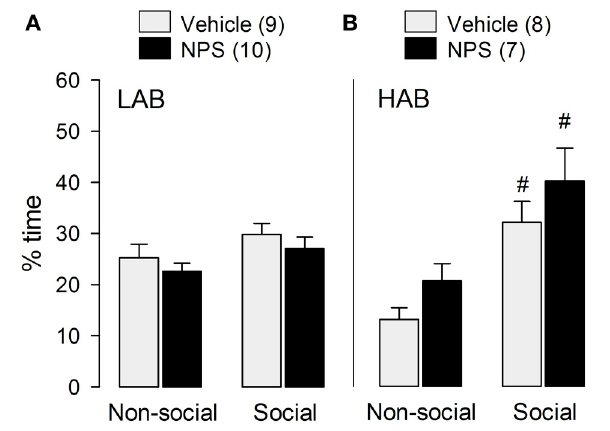
FIGURE 2 | Behavior of LAB (A) and HAB (B) rats in the social preference test. NPS (1nmol) or vehicle were applied icv 30min before testing. Social preference was reflected by the time the experimental rats spent sniffing the non-social (empty cage) and the social stimulus, respectively. NPS (1nmol) was applied icv 30min before testing. Time of non-social and social investigation are calculated as percentage of total time (4min). Numbers in parentheses indicate group size. Data are means + s.e.m., # p < 0 . 05 vs. non-social stimulus; 2 × (2) mixed model ANOVA (drug treatment [between subject] × stimulus